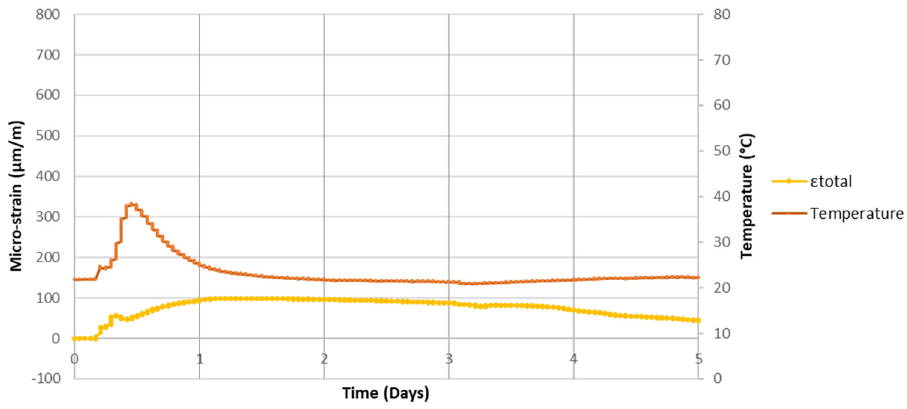
Figure 3. Strains and temperature with time. Prism under ambient conditions (detailed information of the first day of the test).